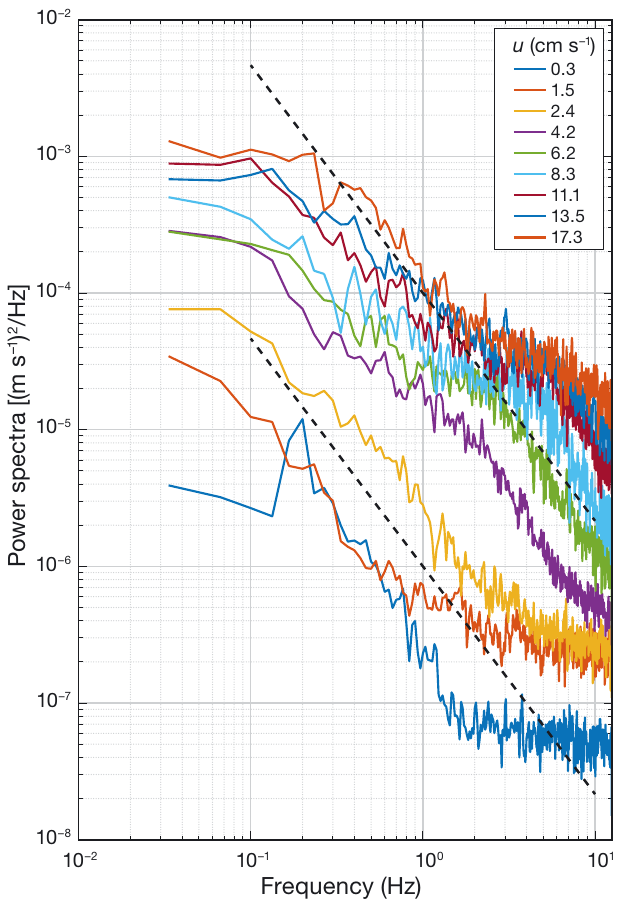
Fig. 6. Energy spectra for the u component of the velocity over a mud substrate. Flow begins to exhibit Kolmogorov’s 5/3- slope theory in the inertial subrange after near-bed velocities exceed 2 cm s −1 along the main axis. A noise floor value close to 5 × 10 −7 (m s −1 ) 2 Hz −1 can be observed for the lowest velocity values, occurring when the motor was off. A 5-fold increase in noise occurred with the onset of the rately when implementing substrate- dependency in numerical models for resuspension.